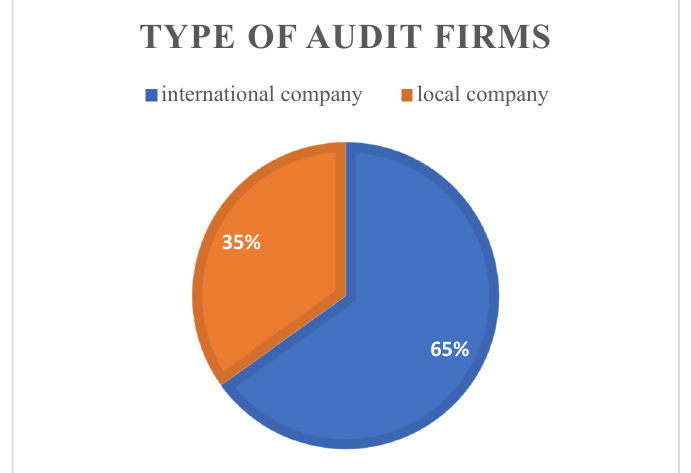
Figure 2. Dominating presence of respondents from international audit firms.